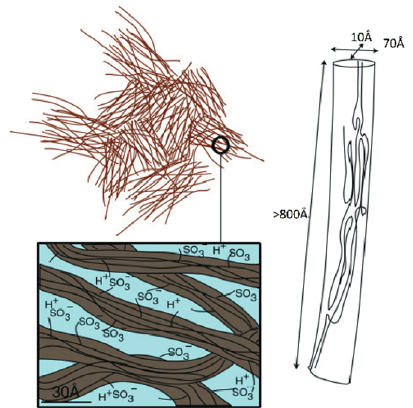
Figure 5. New insight of a Nafion membrane multiscale, structural model for Nafion membranes. Rod-like polymer aggregations (adapted from [58,104]).